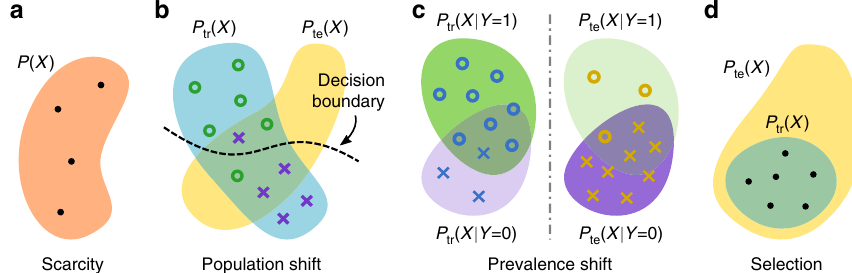
Fig. 1 Key challenges in machine learning for medical imaging. a Data scarcity and b – d data mismatch. X represents images and Y , annotations (e.g. diagnosis labels). P tr refers to the distribution of data available for training a predictive model, and P te is the test distribution, i.e. data that will be encountered once the model is deployed. Dots represent data points with any label, while circles and crosses indicate images with different labels (e.g. cases vs.